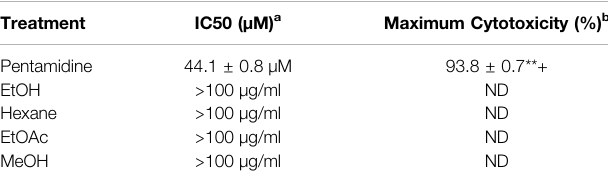
TABLE 2 | Determination of the cytotoxicity of pentamidine, EtOH extract, and hexane, EtOAc, MeOH fractions, of propolis from the semi-arid region of Bahia, Brazil against J774.A1 cells using the MTT